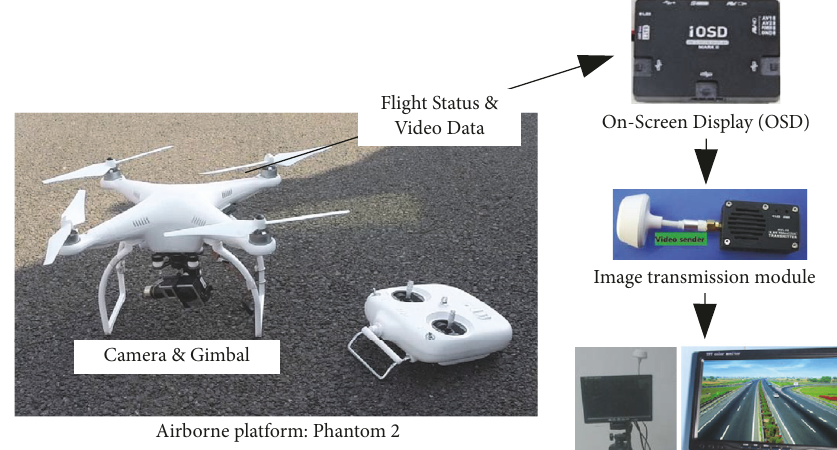
Figure 5: UAV system